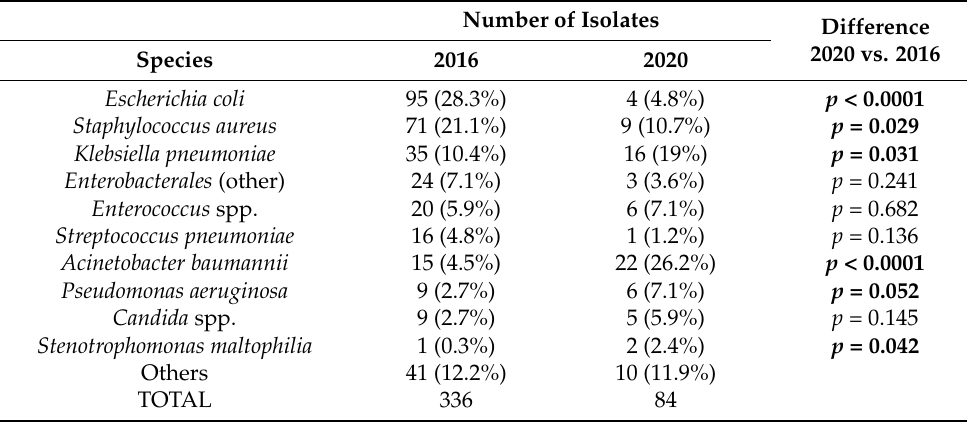
Table 1. Pathogens isolated from blood cultures.